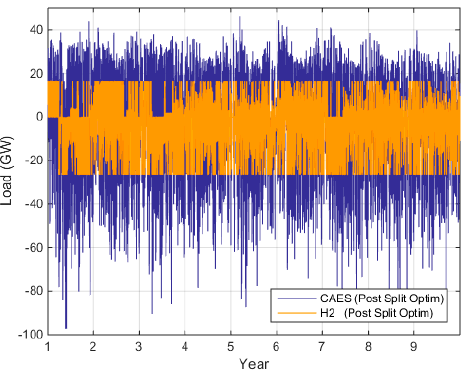
Figure 18. Work cycles for hydrogen and CAES created with a data resolution of 5 min. Batteries not yet considered.